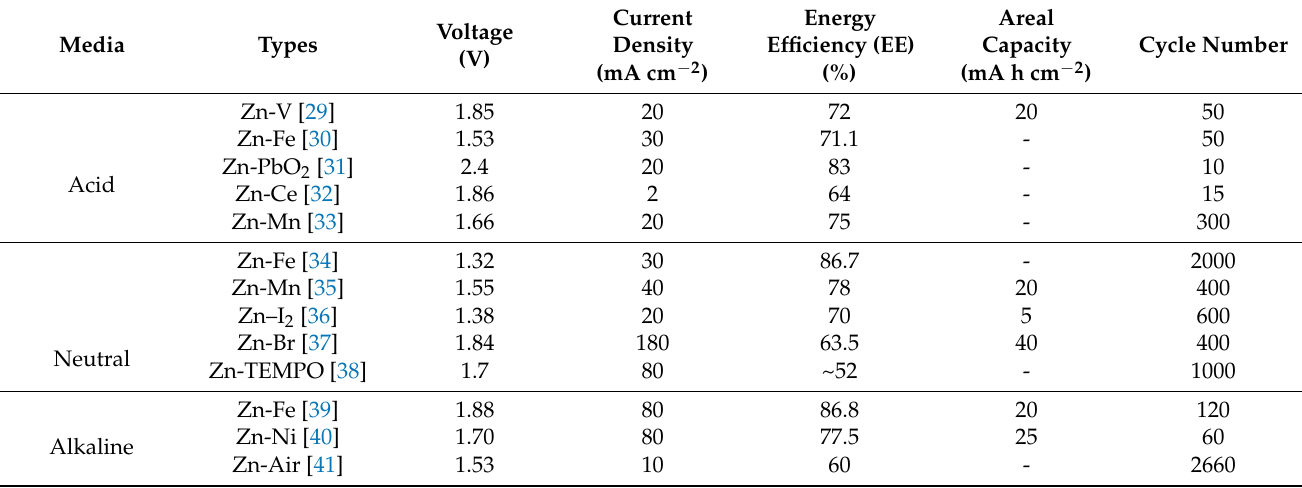
Table 1. Comparison of various types of